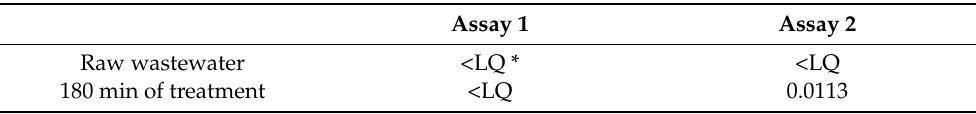
Table 4. Quantitative determination of silver (mg L − 1 ) in raw wastewater and wastewater treated with chitosan pellets containing AgNPs, by inductively coupled plasma optical emission spectroscopy (ICP-OES).